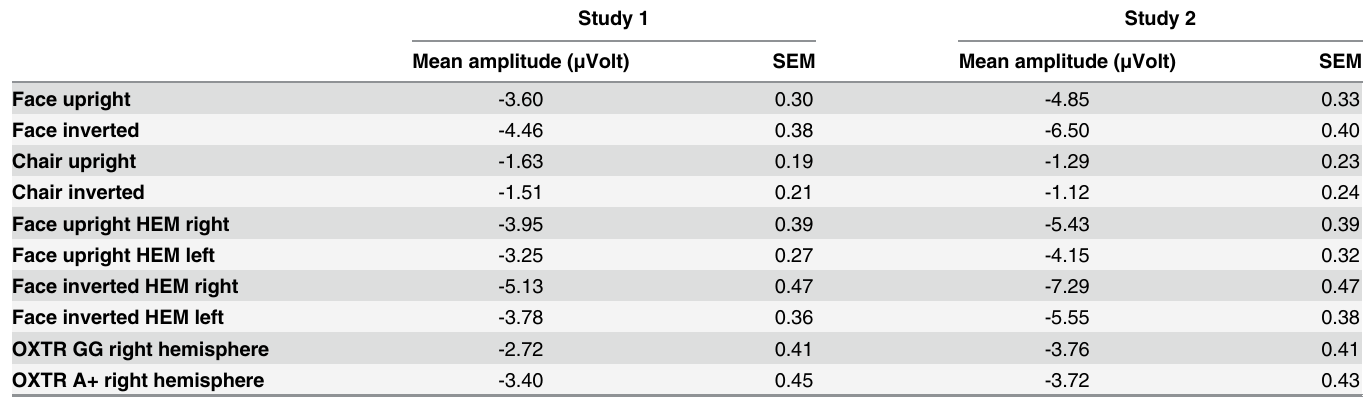
Table 1. Mean amplitude ( μ Volt) and Standard Error of the Mean (SEM) in response to position of neutral faces (upright vs. inverted) and chairs (upright vs. inverted); Hemisphere (HEM), Oxytocin-receptor-gene-polymorphism rs53576 (OXTR).